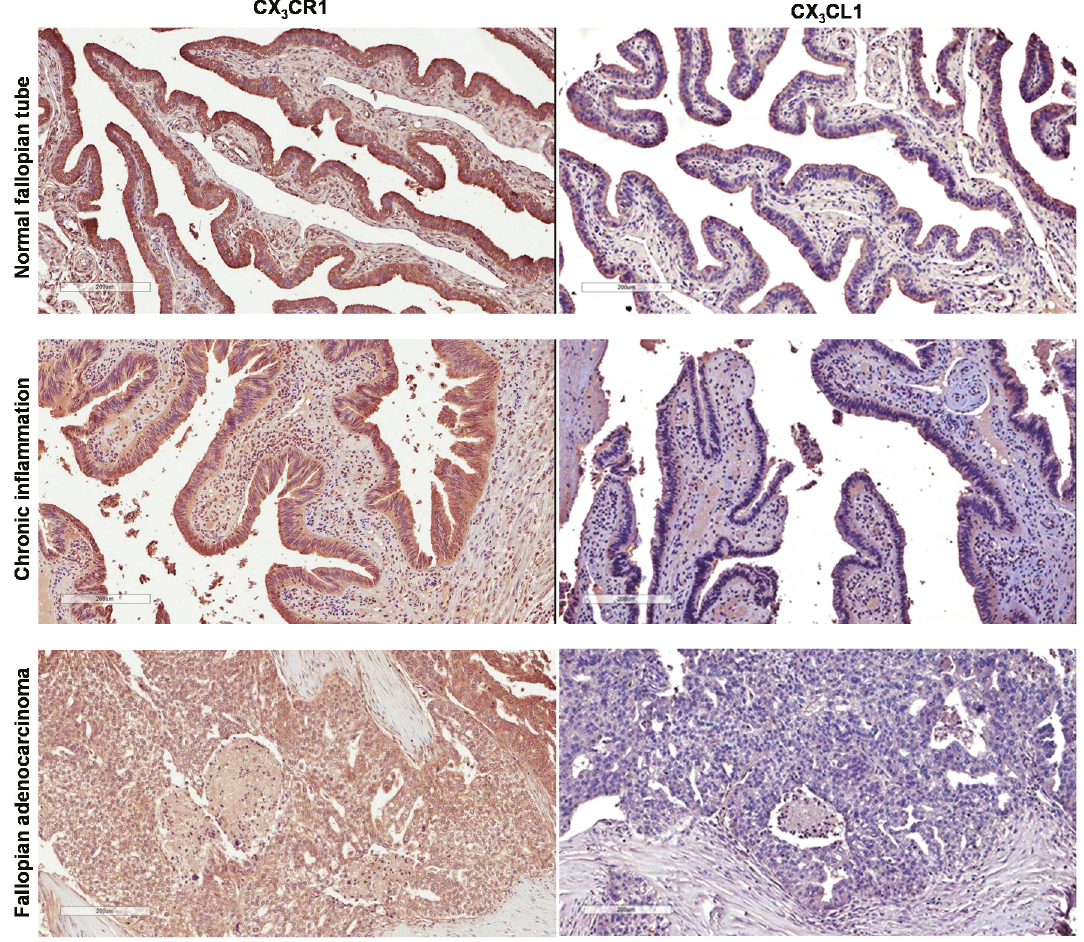
Figure 1. Expression of CX 3 CR1 and CX 3 CL1 in specimens of human normal fallopian tube epithelium, fallopian tube with chronic inflammation, and fallopian carcinoma. Specimens were examined for expression of CX 3 CR1 and CX 3 CL1 by immunohistochemistry. Brown—CX 3 CR1; blue—hematoxylin. Images were generated using an Aperio ScanScope digital slide scanner. Cores at positions A4 (fallopian adenocarcinoma), C4 (fallopian tube with chronic inflammation), and E9 (cancer adjacent normal oviduct tissue) were imaged (for additional information refer to Tables S1 and S2). Magnification—10×. Bar, 200